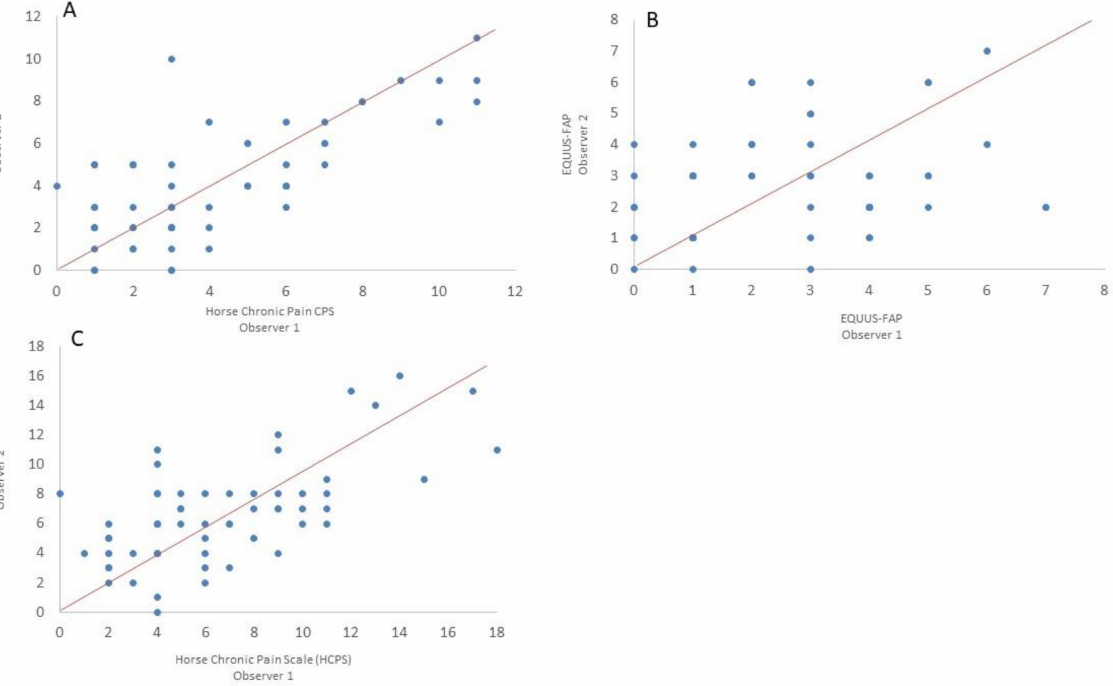
Figure 1. Inter-observer reliability. ( A ) Horse Chronic Pain Composite Pain Scale (HCP CPS), intraclass correlation coefficient (ICC) = 0.84 (confidence interval CI: 0.74–0.91, p < 0.001). ( B ) Equine Utrecht University Scale for Facial Assessment of Pain (EQUUS-FAP), ICC = 0.45 (CI: 0.058–0.67, p < 0.05). ( C ) Horse Chronic Pain Scale (HCPS; combination of HCP CPS and EQUUS-FAP), ICC = 0.78, (CI: 0.62–0.87, p < 0.001). Solid red lines show y = x, ( n =